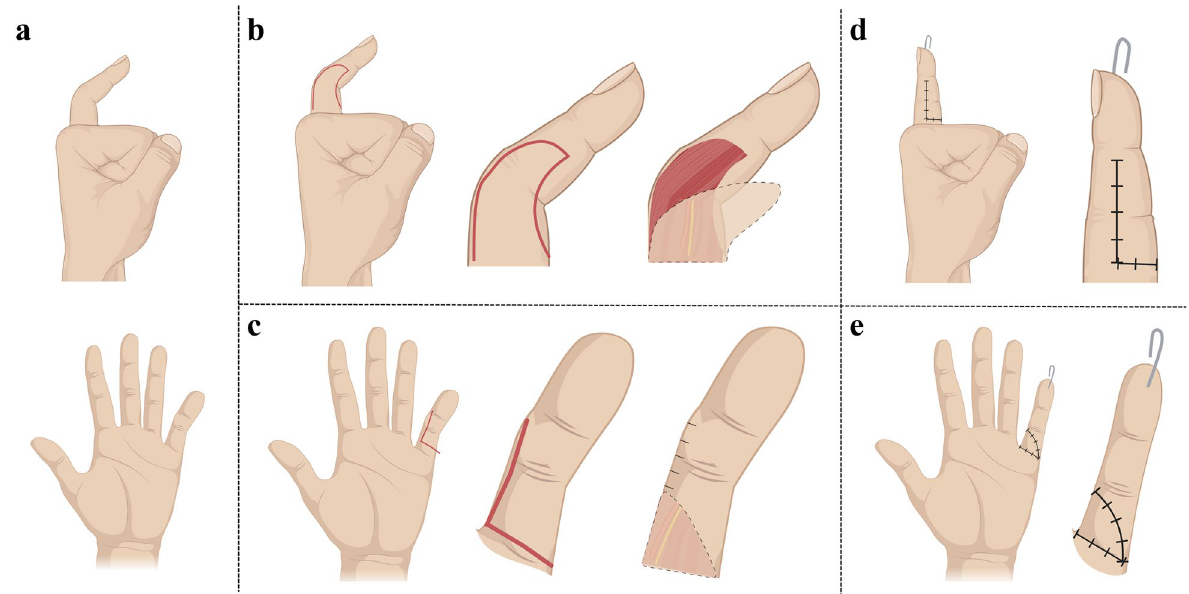
Figure 2. Representative illustrations of camptodactyly of the 5th digit. ( a ) Frontal and lateral views of the 5th digit before surgery. ( b ) Design of the tongue-shaped flap, with the longitudinal edges limited within the radial surface, and the distal edge made slightly exceeding the proximal interphalangeal joint line. ( c ) The volar incision. ( d ) The lateral view of the digit flap transfer, with direct suturing performed for closure of the